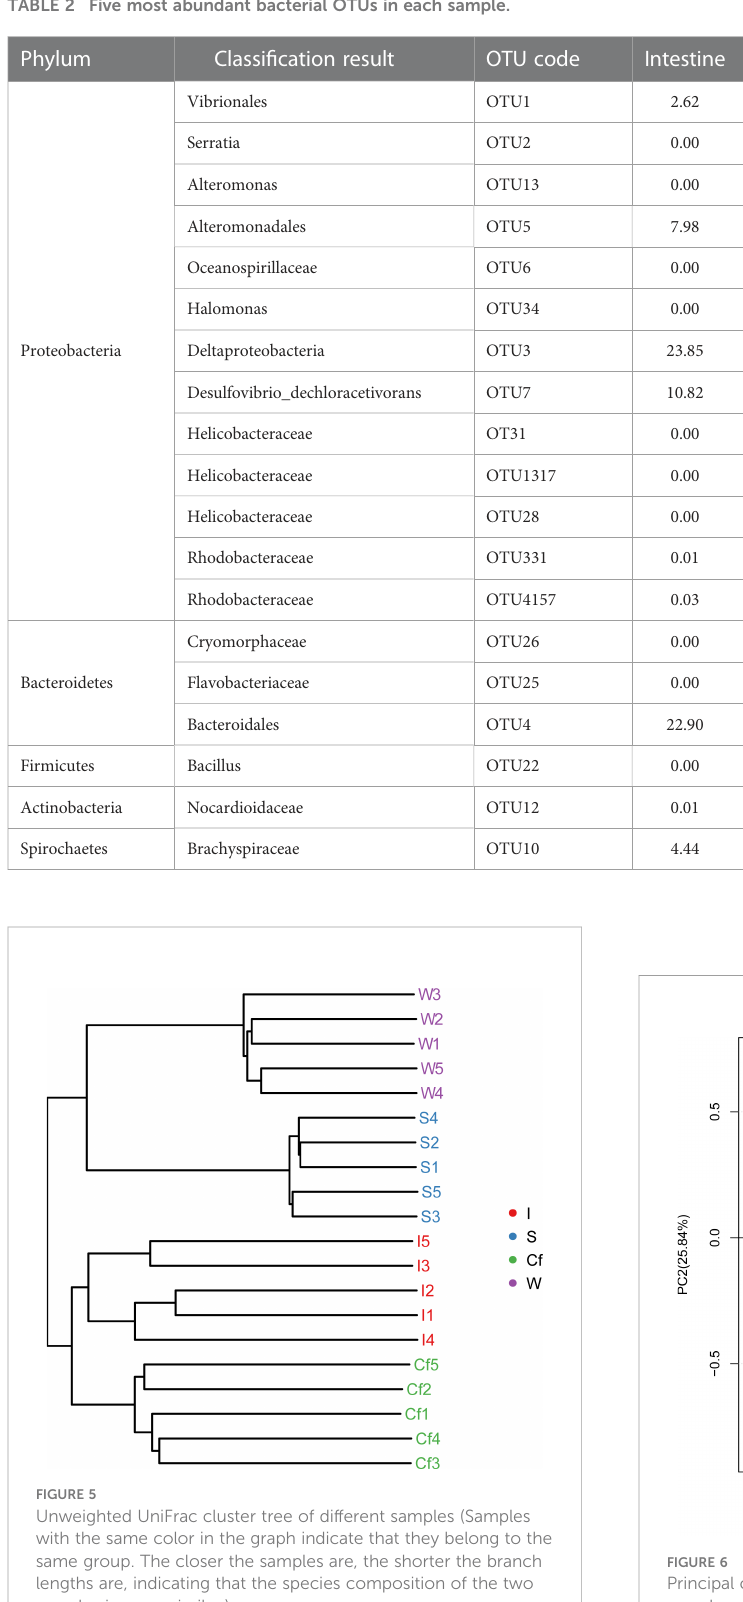
TABLE 2 Five most abundant bacterial OTUs in each sample.